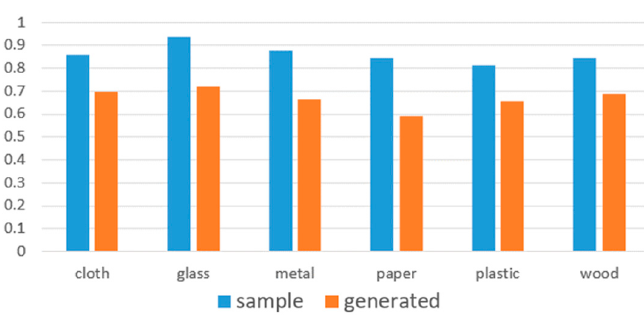
Figure 18. Accuracy of each material class in main (generated) and preliminary (sample) experiments.